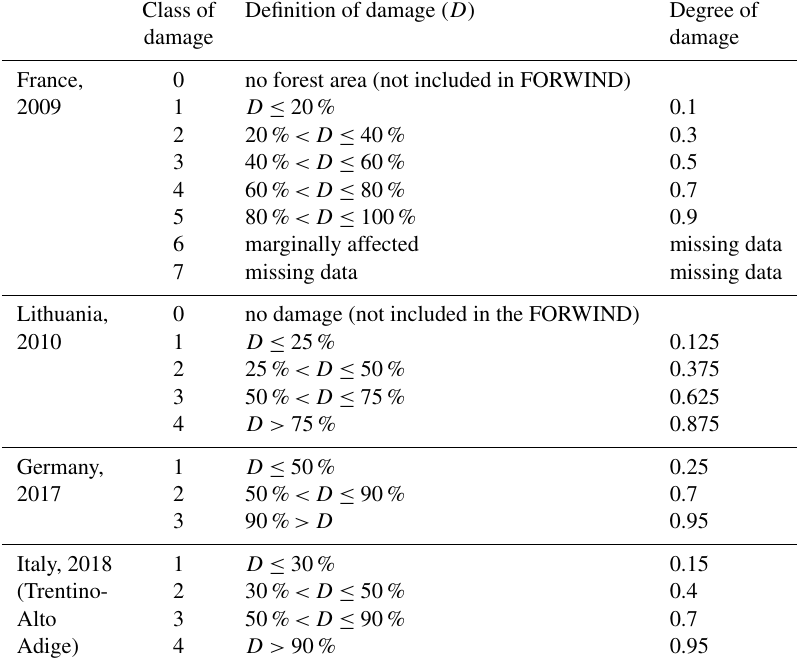
Table 2. Conversion table for passing data from class of damage to degree of damage. Records of windstorms that occurred in Italy in 2015 (Toscana) and in 2018 (Veneto) are already expressed as damage degree in a consistent range between 0 (no damage) and 1 (full destruction of forest pattern).